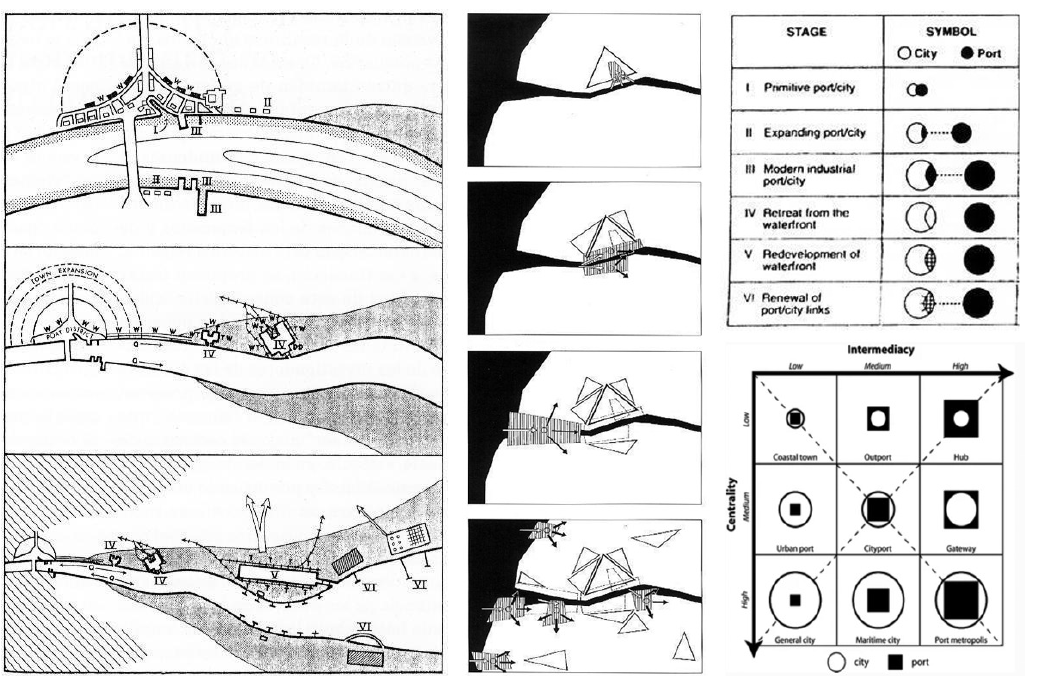
Figure 1. Port‐city dynamics. From left to right and from top to bottom: a) Anyport (Bird, 1963, pp. 29, 31, 33); b) Historical port‐city evolution (Meyer, 1999, p. 23); c) Development dynamics of the port‐city interface (Hoyle, 2000, p. 405); and d) Matrix of port‐city relations (Ducruet & Lee, 2006, p.109).